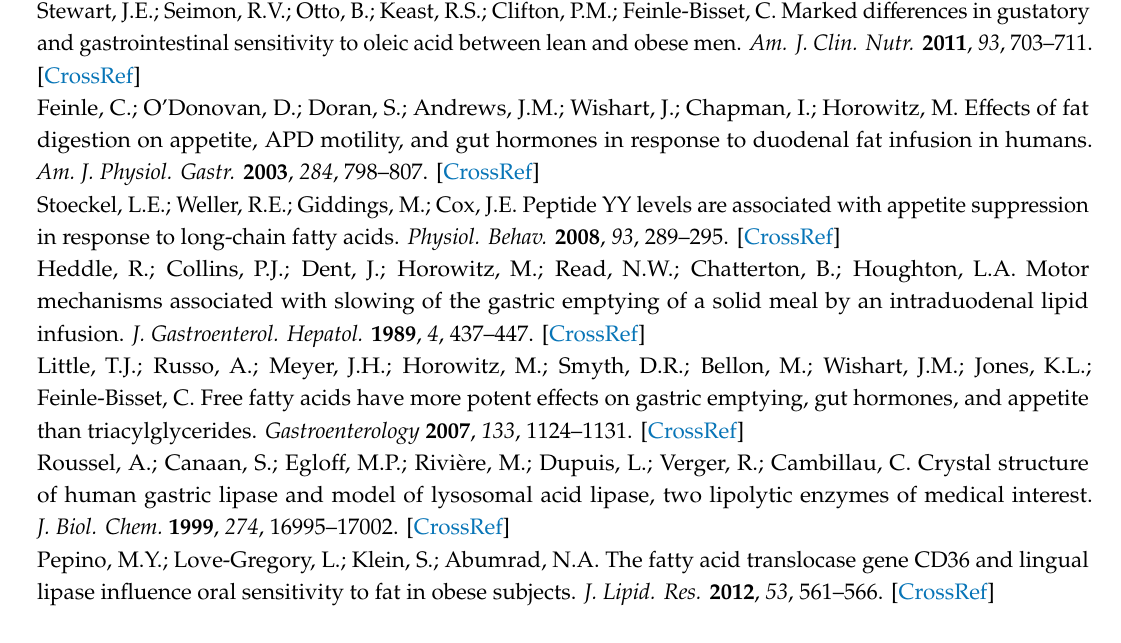
Image S1: Appetite Questionnaire, Table S1: Comparison of appetite rating AUCs between days one and two and days three and four, Figure S1. Means and 95% CIs for self-reported appetite ratings in participants ( n = 31) on days one and two (ongoing FTT tests) and days three and four (one initial FTT test) prior to and following mouth rinse treatments over